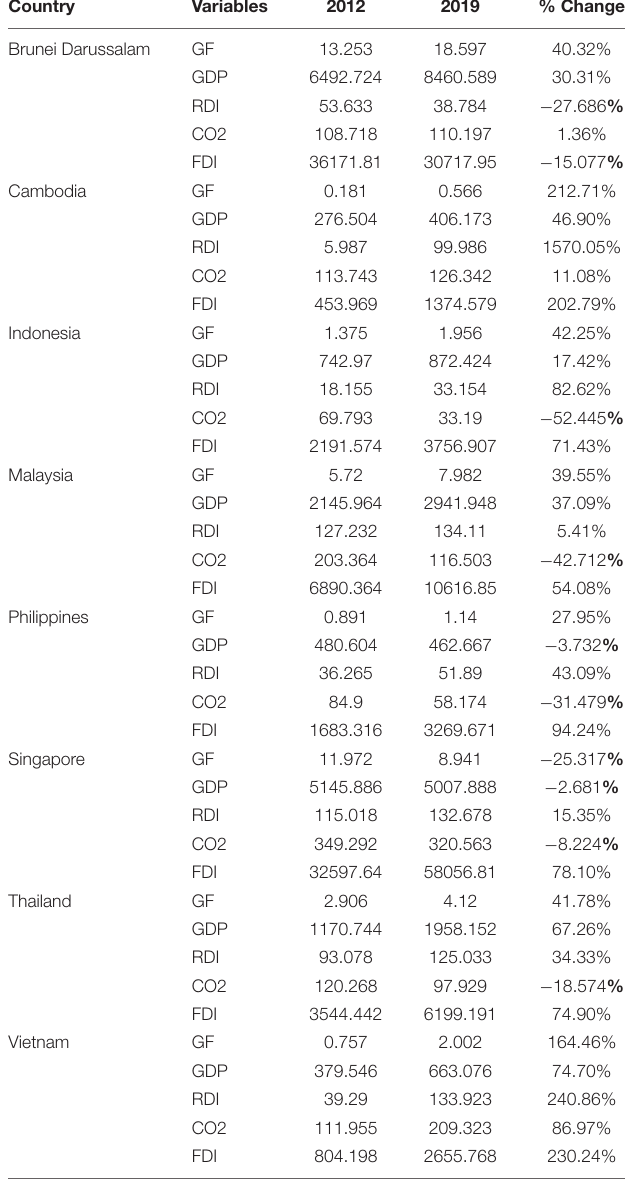
TABLE 3 | Description of statistics (Country-specific). Country